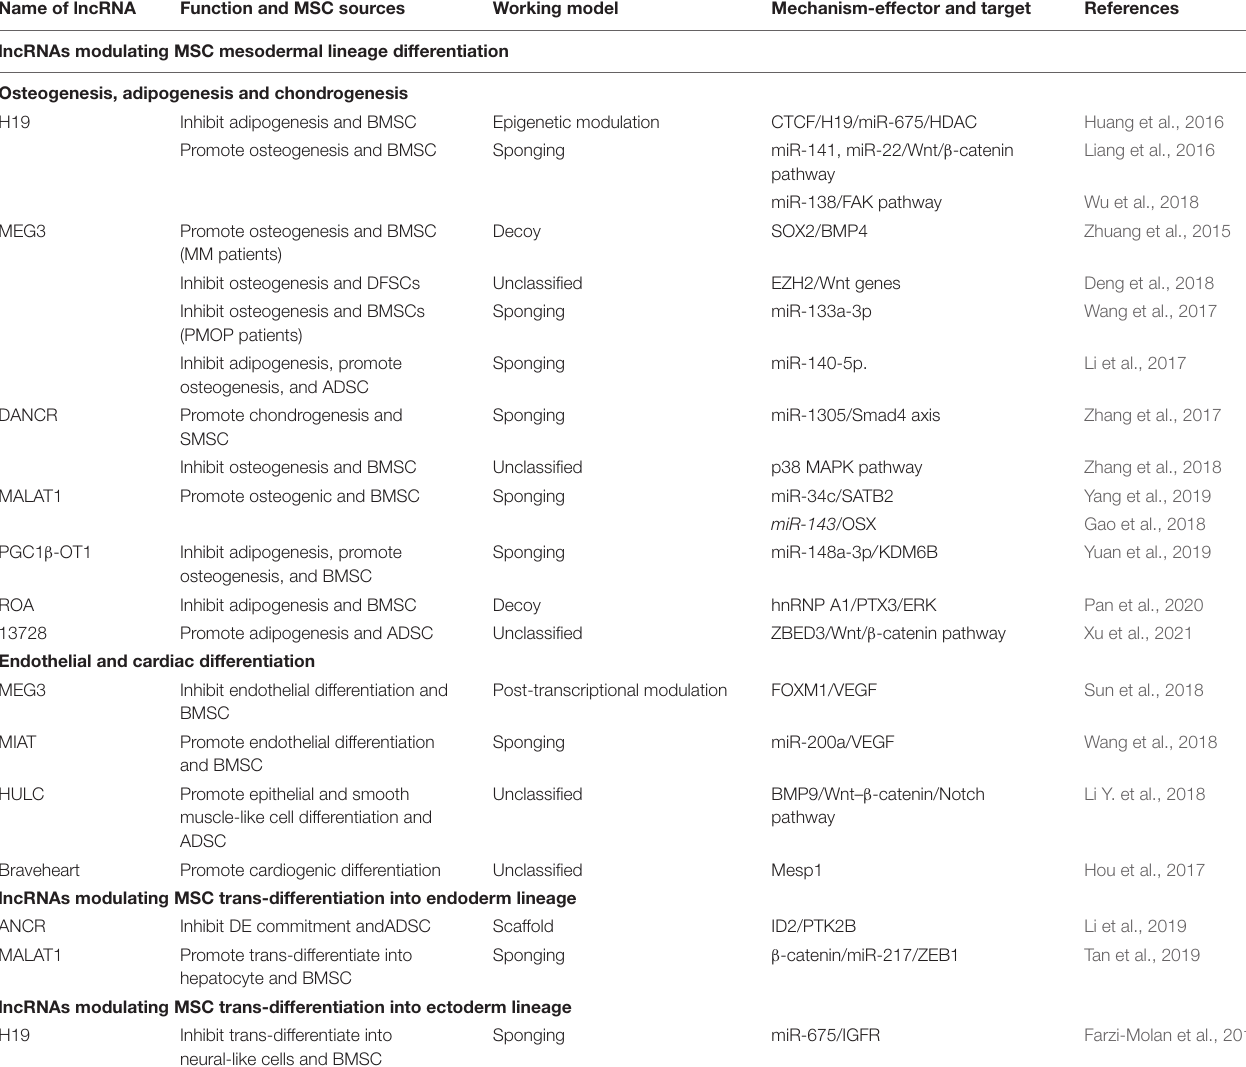
TABLE 1 | MSCs-associated lncRNAs in multi-lineage